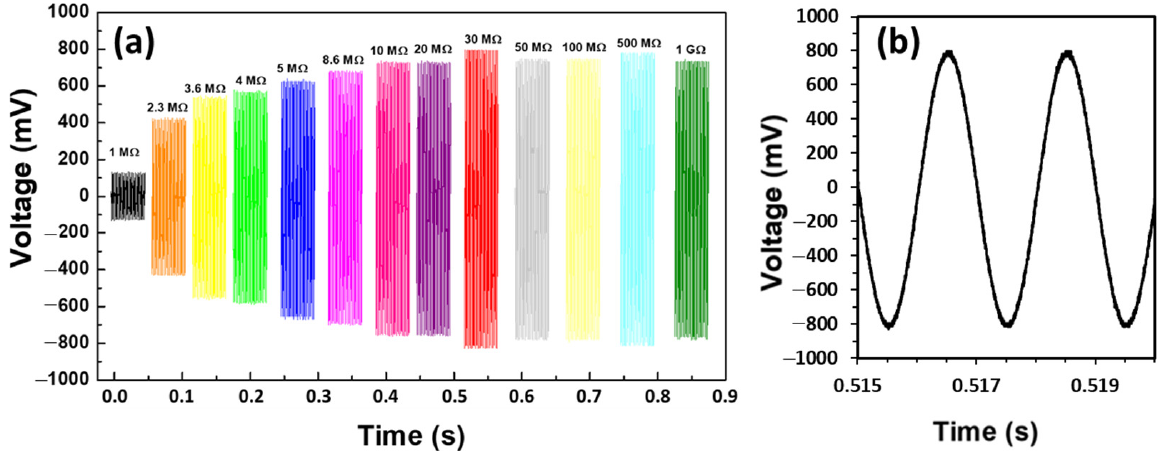
Figure 4. ( a ) Voltage response according to load resistance R L , under vibration mode, with f = 500 Hz. ( b ) The generated signal, with a peak-to-peak value of about 1.4 V.